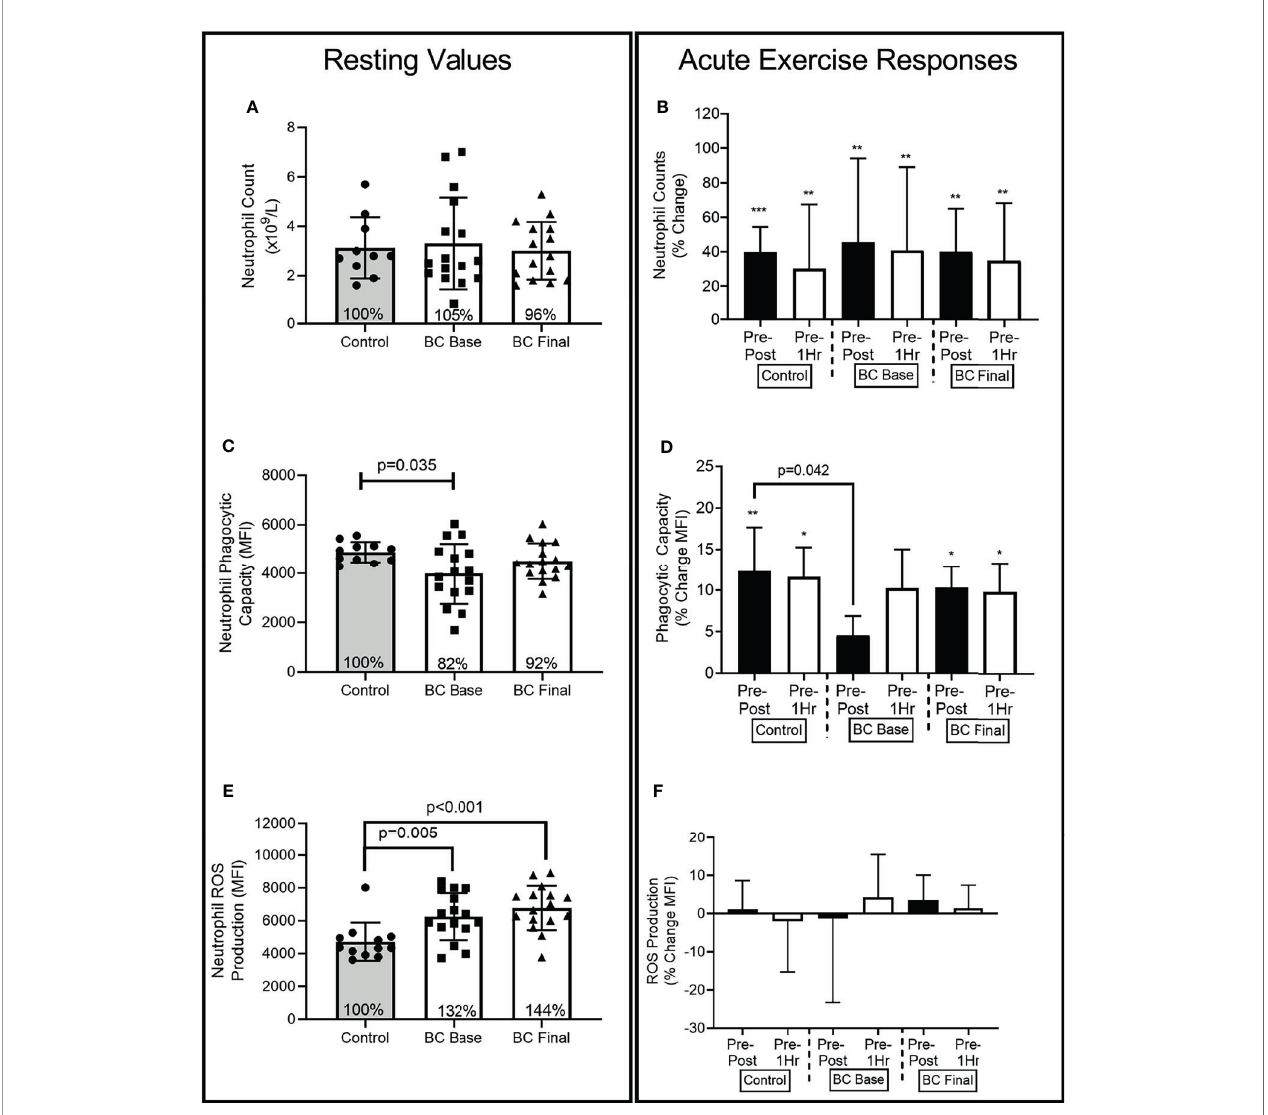
FIGURE 2 | Neutrophil differences between Controls and BCS measured once in Controls, and before and after 16 weeks of exercise in BCS. Panels show, resting values (Left Side) and acute exercise responses (Right Side) for percentage changes pre exercise to immediately post exercise (Pre-Post), and Pre exercise to 1 hour after exercise completion (Pre-1Hr). (A) Neutrophil absolute counts measured once in Controls, and before and after 16 weeks of exercise in BCS. (B) Neutrophil percentage changes in response to acute exercise in Controls, and before and after 16 weeks of exercise in BCS. (C) Neutrophil phagocytic capacity for E.coli (D) Neutrophil phagocytic capacity percentage changes in response to acute exercise. (E) Neutrophil ROS production for E.coli (F) Neutrophil ROS production percentage changes in response to acute exercise. *p < 0.05, **p < 0.01 and ***p < 0.001 signi fi cant change for groups acute response. Where shown, the Controls mean values have been assigned 100% to represent the optimal response, and BCS the percentage of Control means. Data are mean